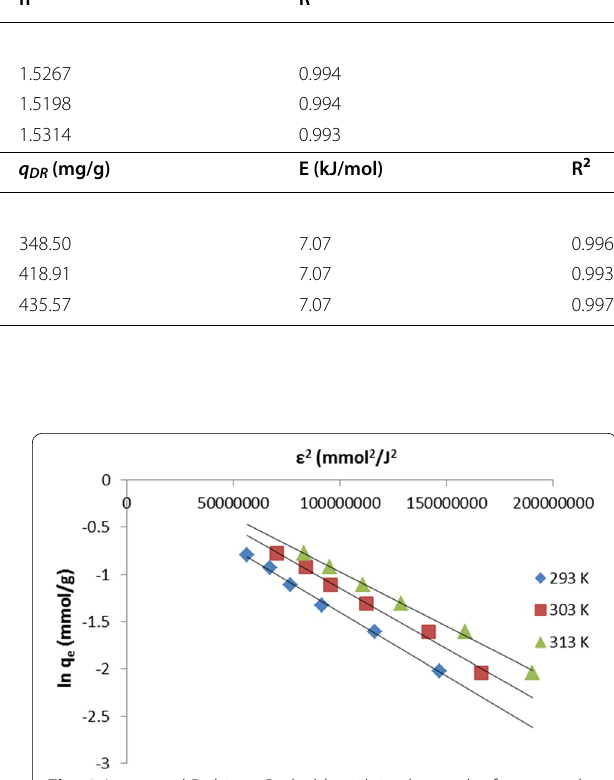
Fig. 6 Linearized Dubinin–Radushkevich isotherm plot for removal of MG by